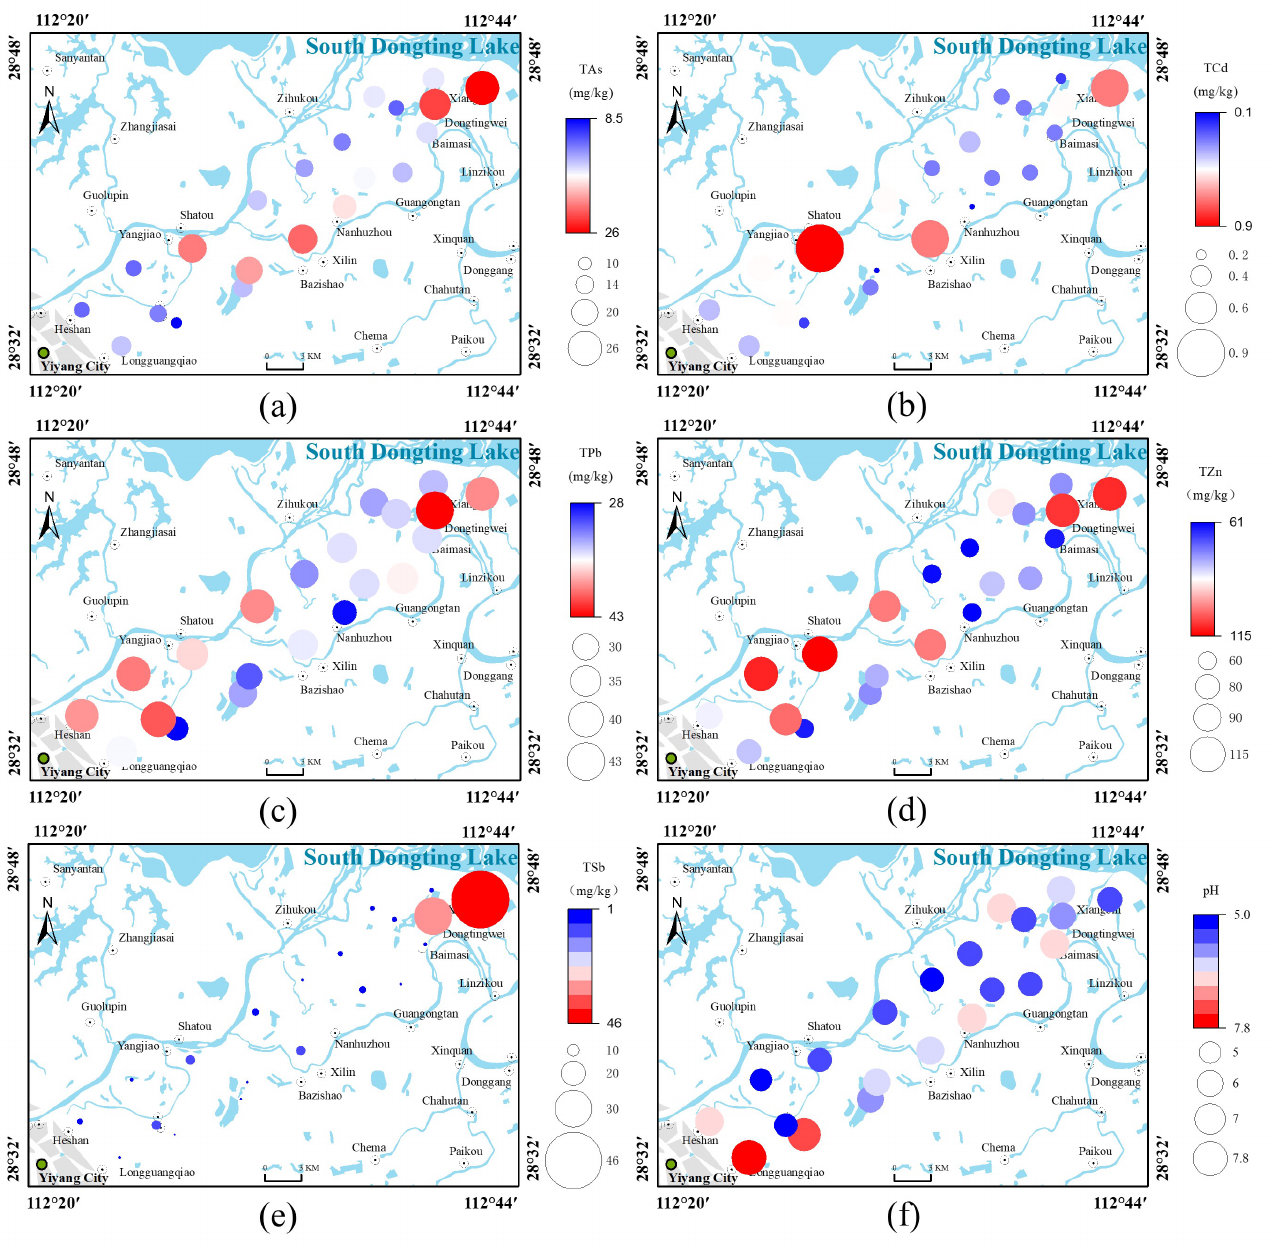
Figure 2. Distributions of the five heavy metals/metalloids and soil pH in the study area: ( a ) As, ( b ) Cd, ( c ) Pb, ( d ) Zn, ( e ) Sb, and ( f )